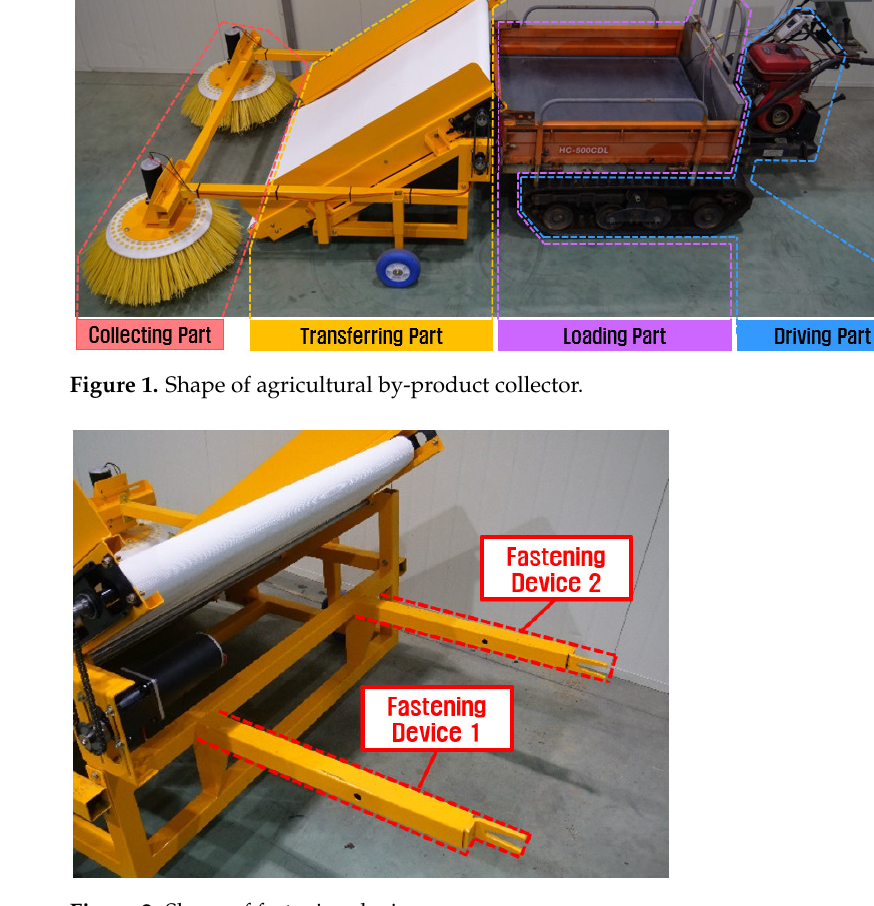
Figure 2. Shape of fastening device.